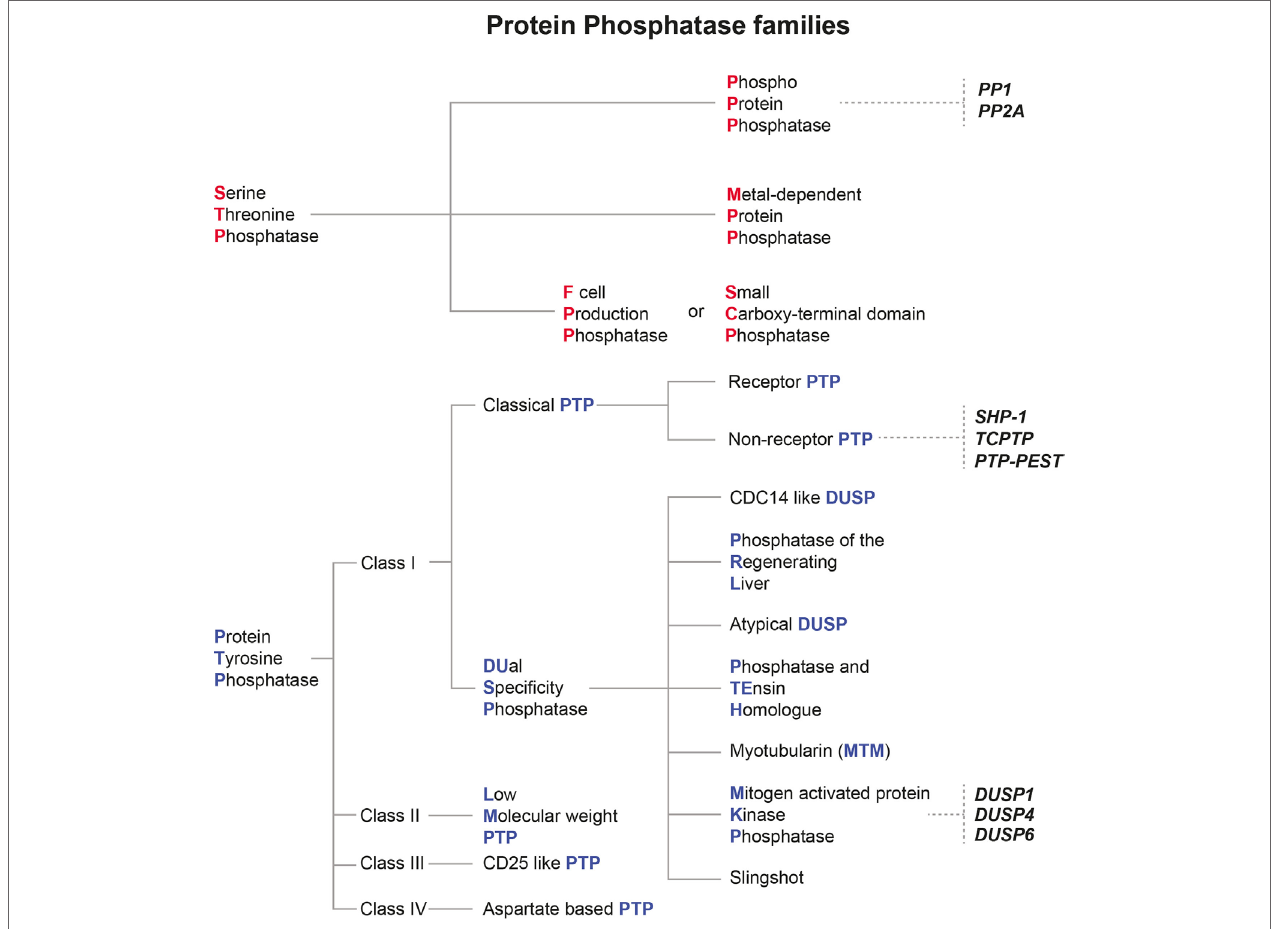
FigURe 2 | Classification of mammalian protein phosphatase families and their relevance for Leishmania infection. Protein phosphatases are classified depending on their structural features and their substrate specificity. The two main families of protein phosphatases and their respective subfamilies are depicted here. Serine threonine phosphatases are marked with red initials, whereas protein tyrosine phosphatases are given with blue initials. Host protein phosphatases which were already shown to affect the outcome of Leishmania infections are written in bold and italic black